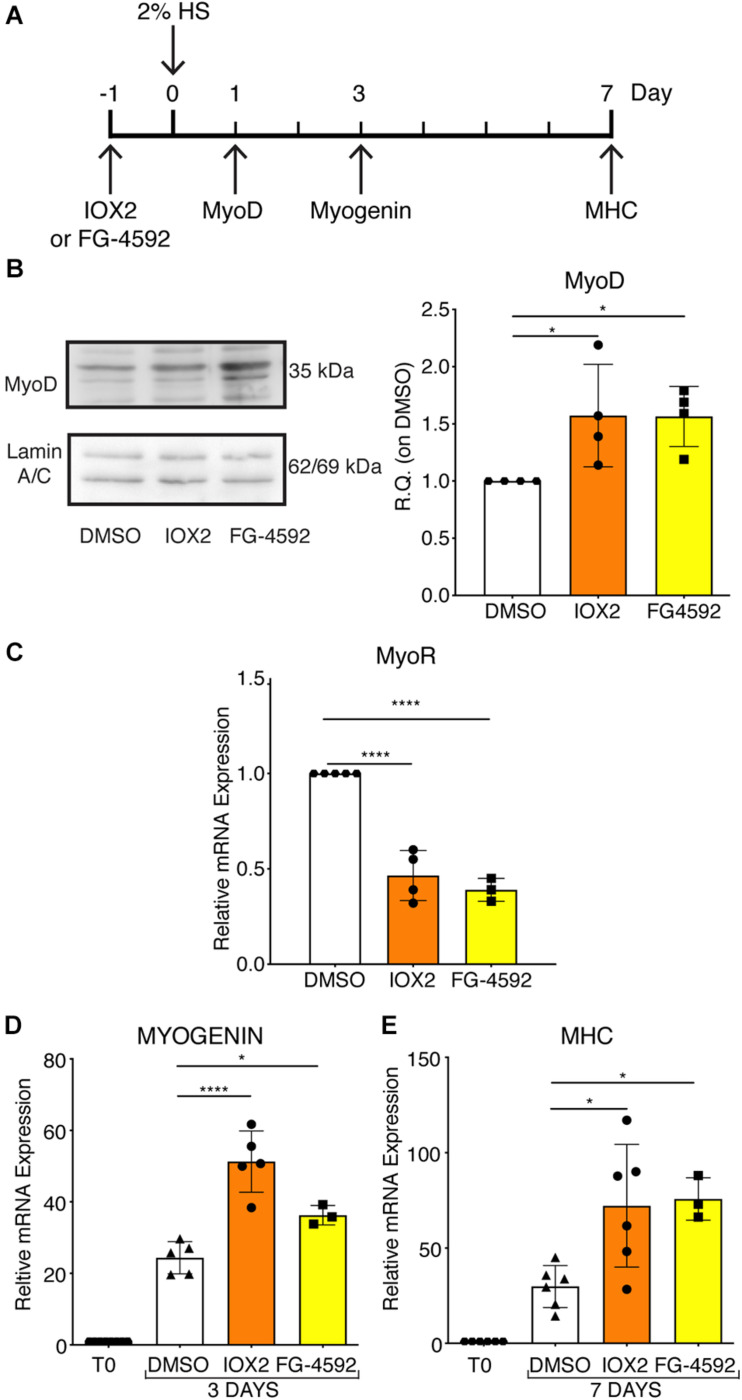
Modulation of myogenic differentiation markers upon pharmacological hypoxia. (A) Schematic representation of myogenic marker during skeletal muscle differentiation. (B) Western blot analysis and relative quantification of MyoD nuclear localization of murine myoblasts treated for 24 h with IOX2 or FG-4592. The nuclear marker Lamin A/C was used as the housekeeper (n = 4). (C) qPCR analysis of MyoR upon prolyl-hydroxylases (PHDs) inhibitors treatment (n = 4 for IOX2 and n = 3 for FG-4592). (D,E) qPCR analyses of MYOGENIN at 3 days (D, n = 5 for IOX2 and n = 3 for FG-4592) and of myosin heavy chain (MHC) at 7 days of differentiation (E, n = 6 for IOX2 and n = 3 for FG-4592), in murine myoblasts pre-treated with IOX2 or FG-4592. Data information: all data represent mean ± SD. *p < 0.05, ****p < 0.0001 (Ordinary one-way ANOVA).